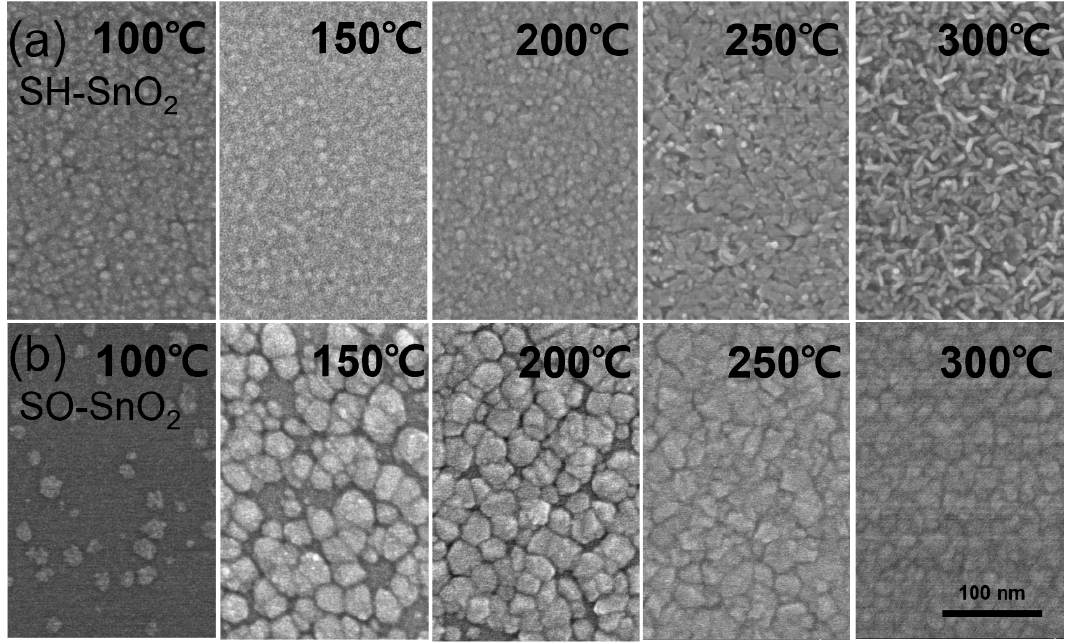
Figure 7. Plane-view high-resolution FESEM images of ( a ) SH-SnO 2 and ( b ) SO-SnO 2 films grown at deposition temperatures of 100–300 °C.